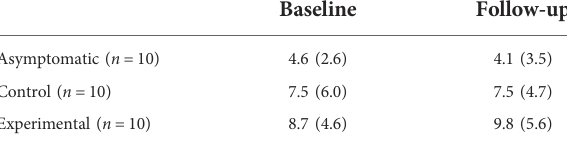
TABLE 5 Mean (SD) epworth sleepiness scale (ESS)